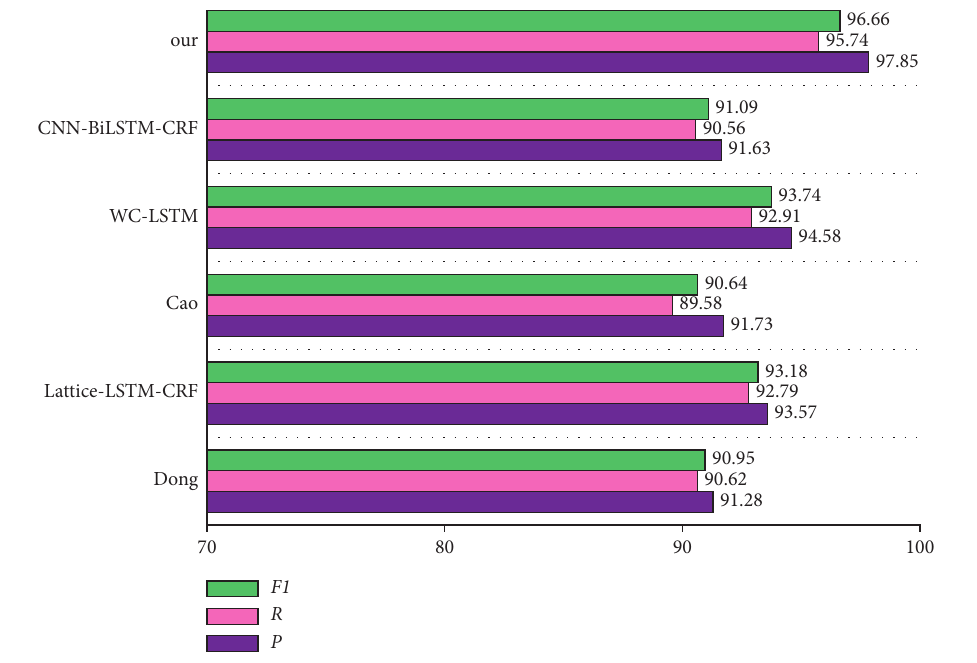
Figure 10: F 1, R , and P comparison of different methods on MSRA dataset. Table 4: Performance comparison of different methods on China People’s Daily corpus.